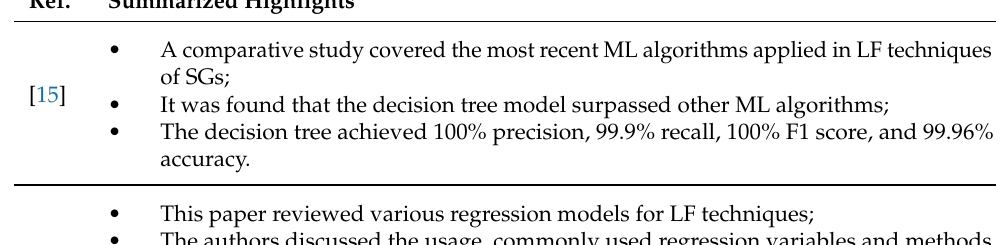
Table 1. Survey papers of load forecasting techniques.